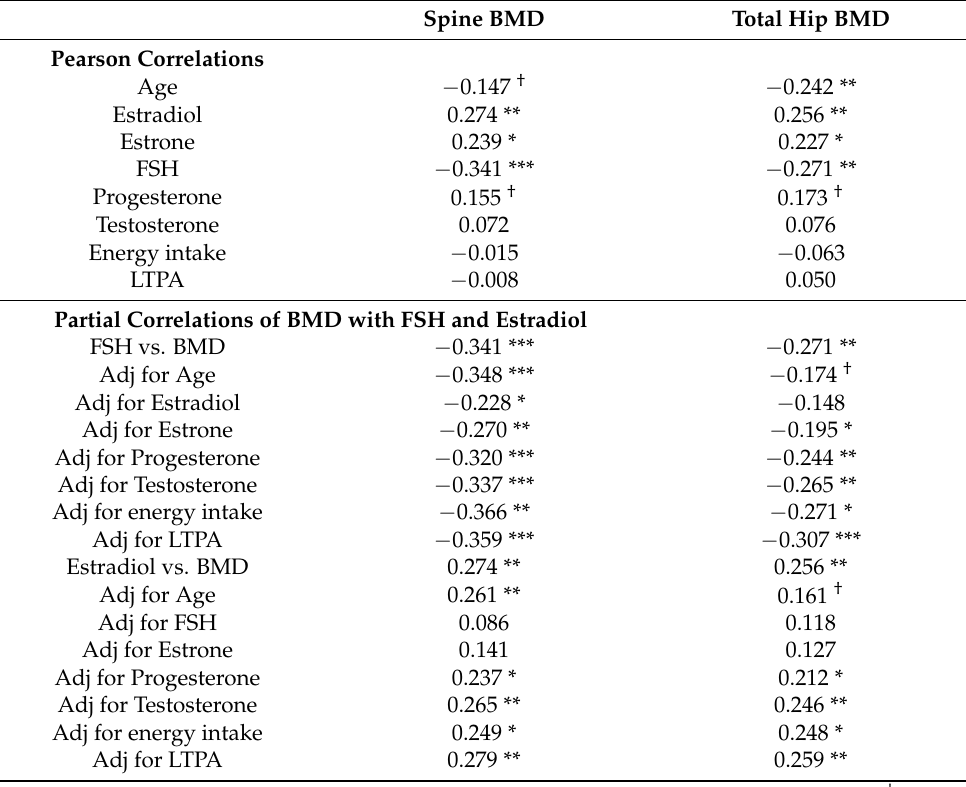
Table 3. Correlations of bone mineral density with age, hormones, energy intake, and physical activity among all groups. Spine BMD Total Hip BMD Pearson